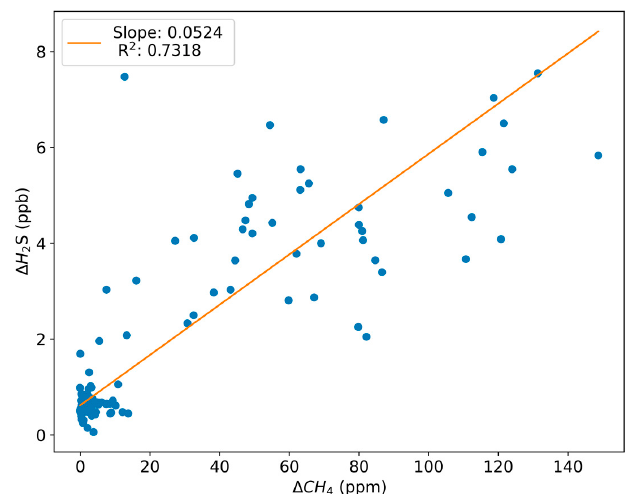
Figure 6. One-minute ∆ H 2 S to ∆ CH 4 MRs from Fresh Kills Day 2 on 3 November 2021: The slope of 0.0524 is used as the ratio between the enhancements of H 2 S and CH 4 , resulting in a ratio of 5.2 ± 2.6 × 10 − 5 mol mol − 1 . Although the ratio is low, the R 2 value of 0.7318 ( n = 144) indicates that the pollutants are strongly